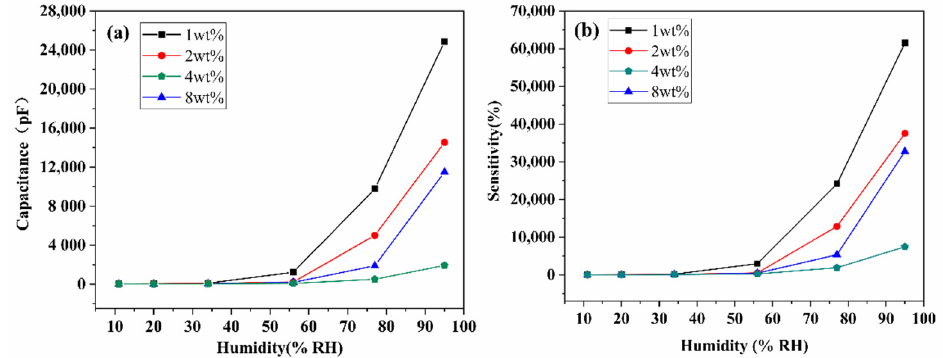
Figure 6. The influence of different doping ratios on ( a ) capacitance and ( b ) sensitivity of SnO 2 /rGO sensor in the range of 11%RH–95%RH.